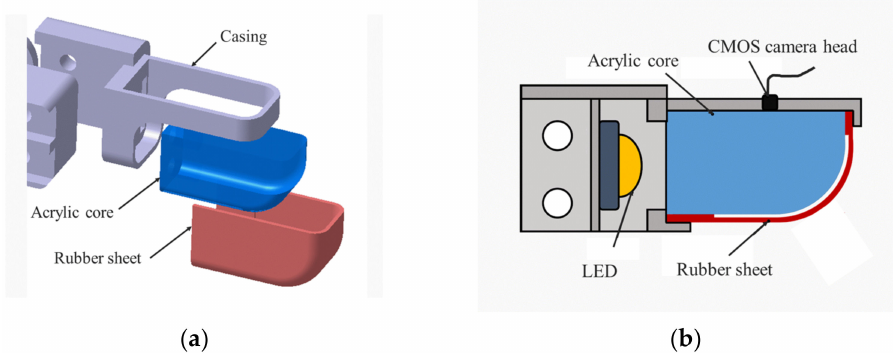
Figure 2. Schematic view of robotic tactile sensor: ( a ) assembly of casing, acrylic core, and rubber sheet and ( b ) structure of tactile sensor, which is composed of an LED, acrylic core, rubber sheet, and miniature CMOS camera